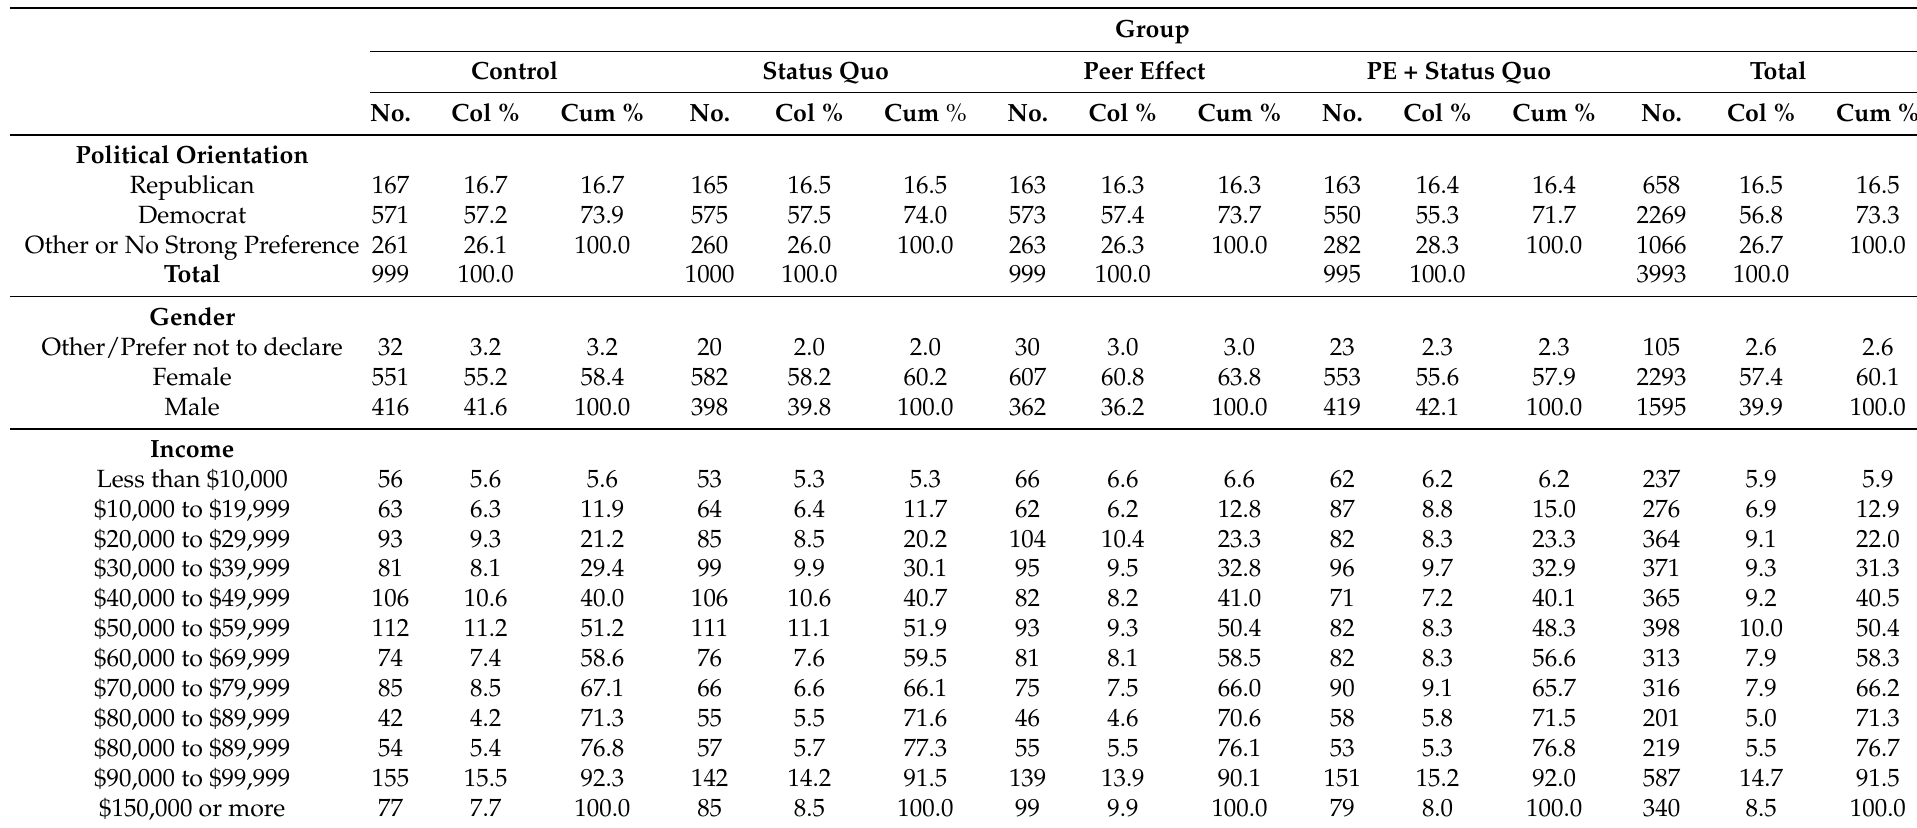
Table 2. Sample balance: the frequency table reports the number, percentage, and cumulative percentage of respondents for the following variables: political orientation, gender, income, education, age, employment, and race. Column 1 shows the distribution for the Control group, Column 2 shows the distribution for the Status Quo group, Column 3 shows the distribution for the Peer Effect group, Column 4 shows the distribution for the Status Quo + Peer Effect group (“PE + Status Quo”), and Column 5 shows the overall distribution in the